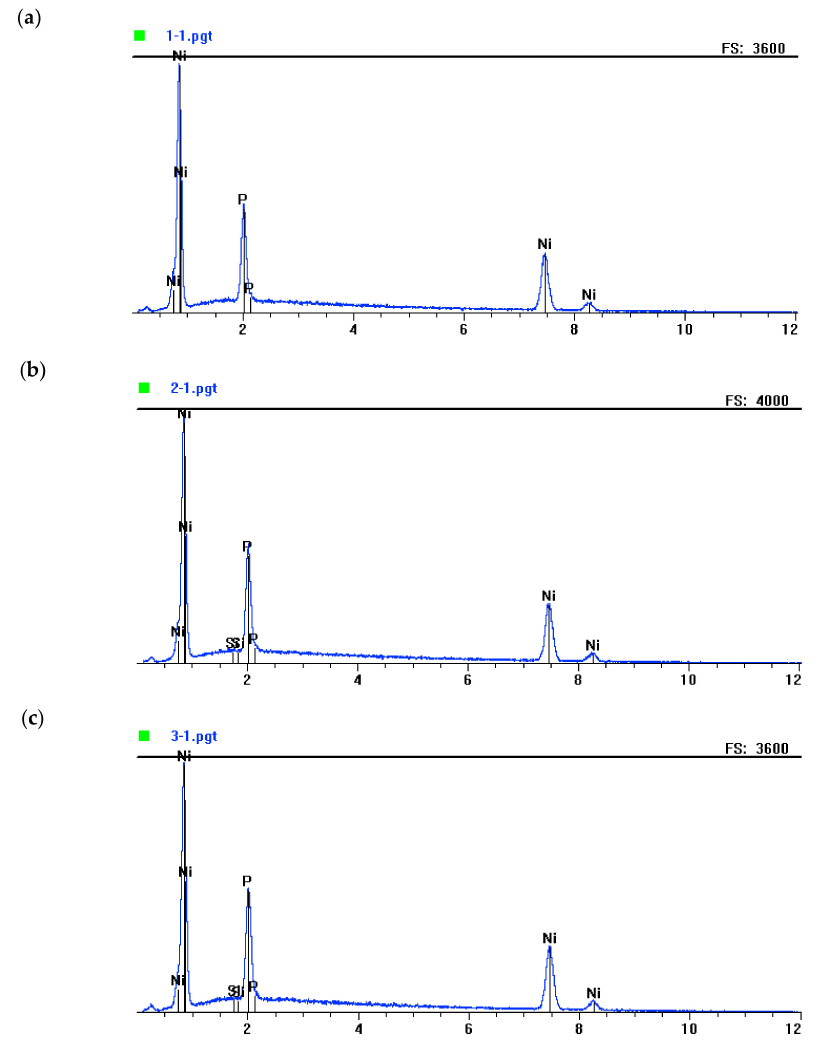
Figure 4. EDS analysis of chemical composition of Ni-P and Ni-P / Si 3 N 4 layers; ( a )—Ni-P, ( b )—Ni-P / Si 3 N 4 (2 g / dm 3 ), ( c )—Ni-P / Si 3 N 4 (5 g / dm 3